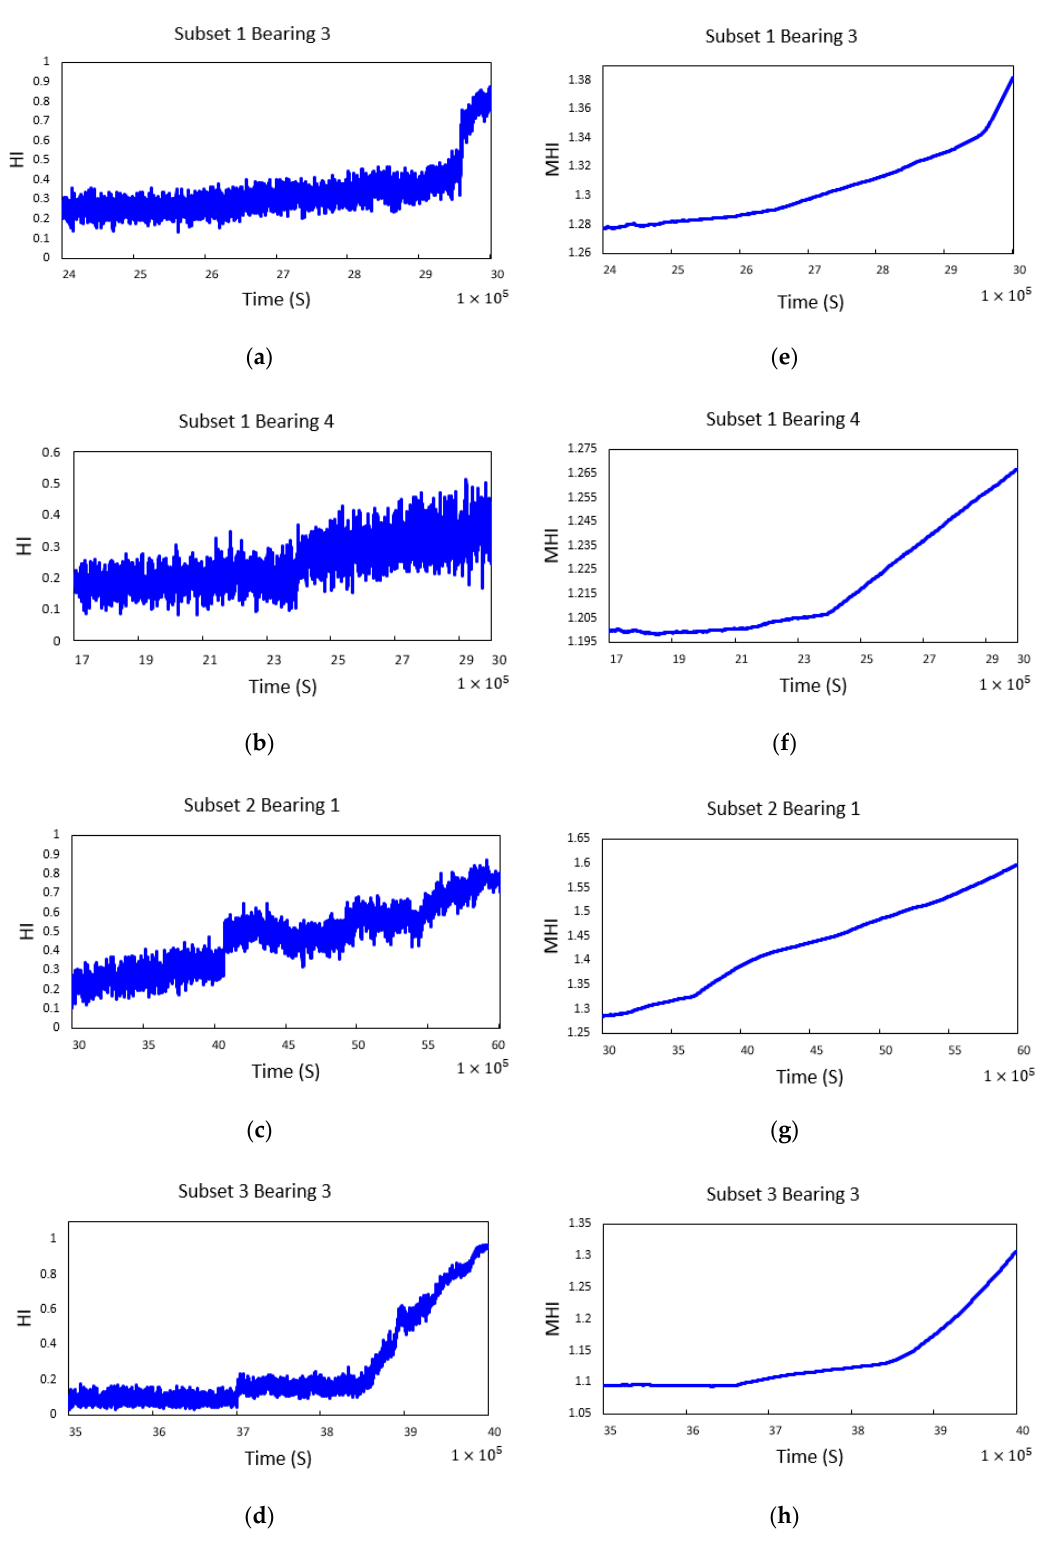
Figure 10. 𝐻𝐼 results for the four IMS bearings: ( a – d ) raw 𝐻𝐼 , ( e – h ) modified 𝐻𝐼 . Figure 10. HI results for the four IMS bearings: ( a – d ) raw HI , ( e – h ) modified HI